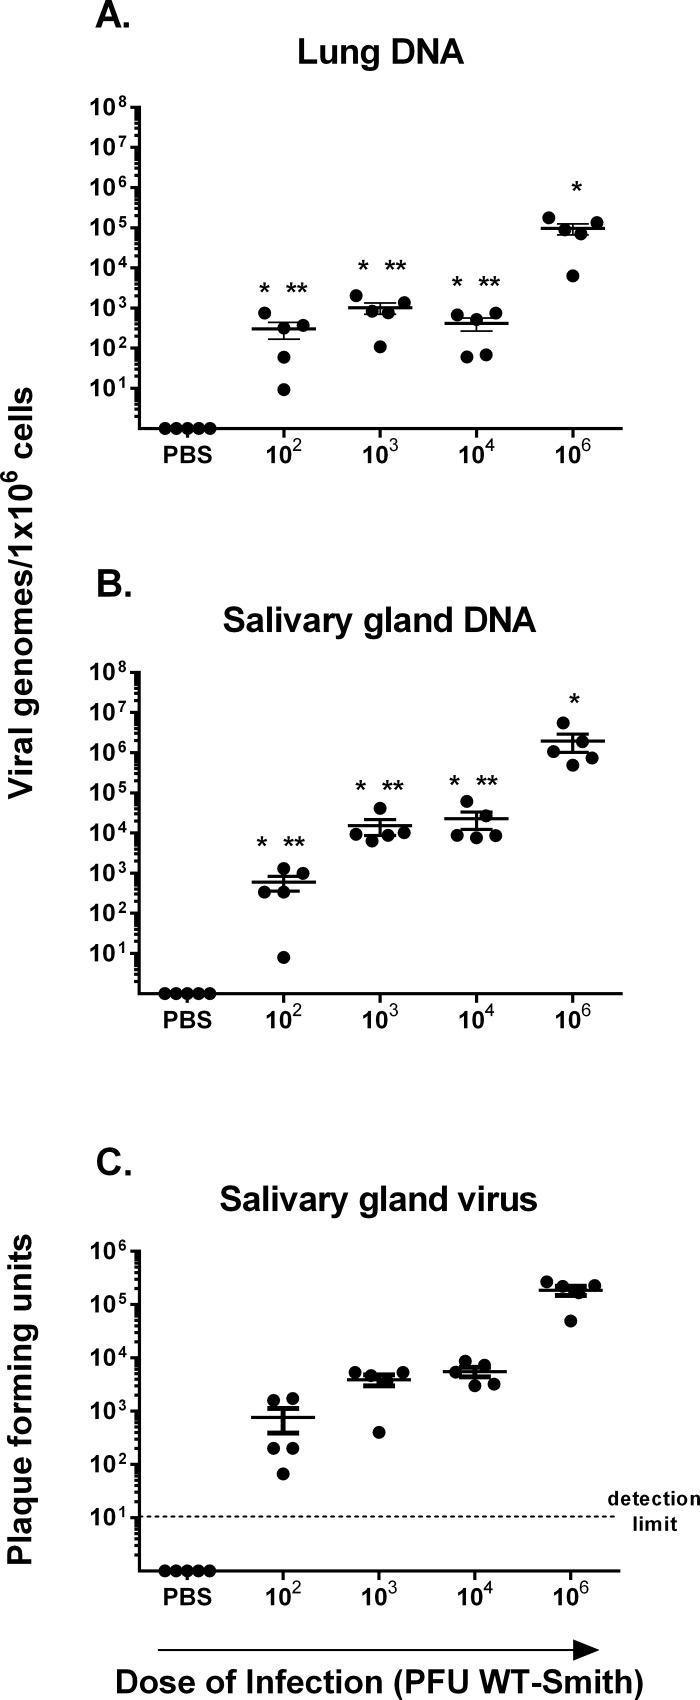
Verification of productive infection and viral DNA load of mice infected with different doses of mCMV Smith.Mice infected at 8–10 weeks of age with 102, 103, 104 or 106 plaque forming units (pfu) mCMV Smith strain or mock treated with PBS were evaluated on day 10 post infection. Viral DNA loads were determined individually for A. lungs and B. Salivary glands of 5 mice per group. C. Salivary gland viral titers were quantitated in pfu/ml to confirm productive infection. Results represent a single experiment with mean values and standard errors indicated by horizontal bar and error bars, with individual dots representing each mouse. Mock treated mice had no detectable viral DNA or infectious virus. * indicates that means were significantly higher than mock. ** indicates that means are significantly lower than mice infected with 106 pfu. Comparisons were by Students t-test using p-value <0.05.